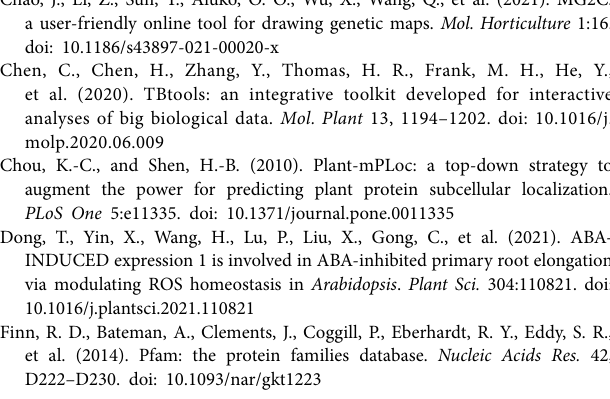
Supplementary Figure 1 | Comparison of the 11 GbPLATZs amino acid sequences. The deeper shading of the letters representing amino acids indicates that the site is more conservative. The last line is the conserved domains of PLATZ TF family, and the other domains were underlined in different colors. Supplementary Figure 2 | Comparison of PLATZ sequences in Arabidopsis thaliana (AT), maize (Zm), rice (Os), soybean (Glyma), loblolly pine (PITA), Norway spruce (MA), and G. biloba (Gb). The branch of the ginkgo gene is shown in red. The size of the point on the branch indicates the self-spreading value of the corresponding branch. The branch length is proportional to the rate of amino acid